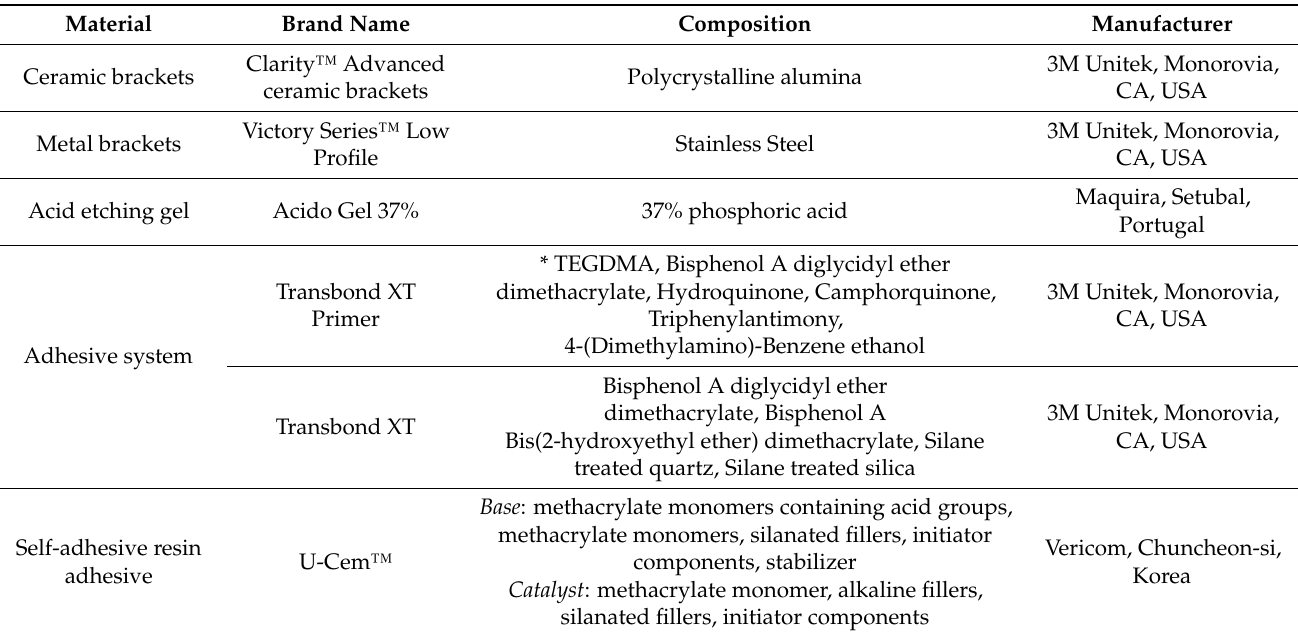
Table 1. Bracket types and adhesive systems used in the